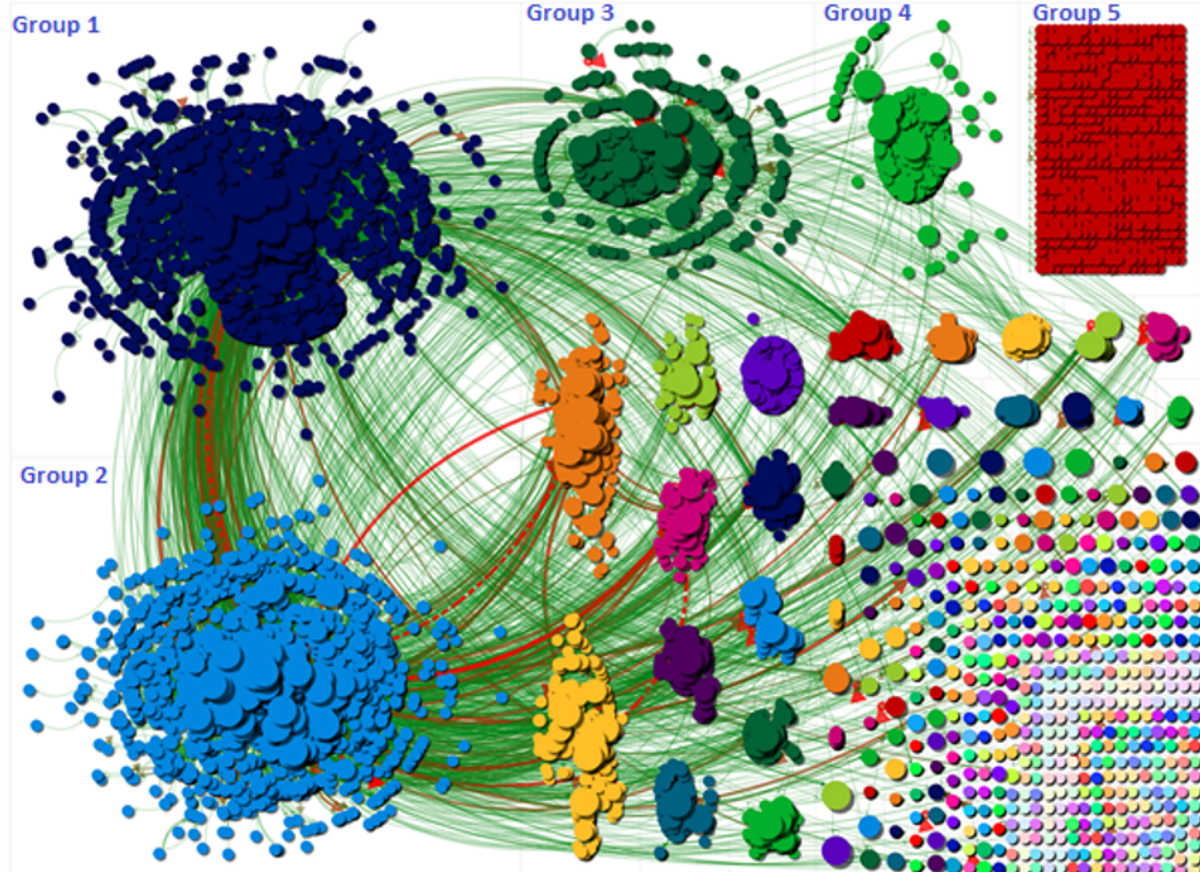
Figure 1. Social network visualization of